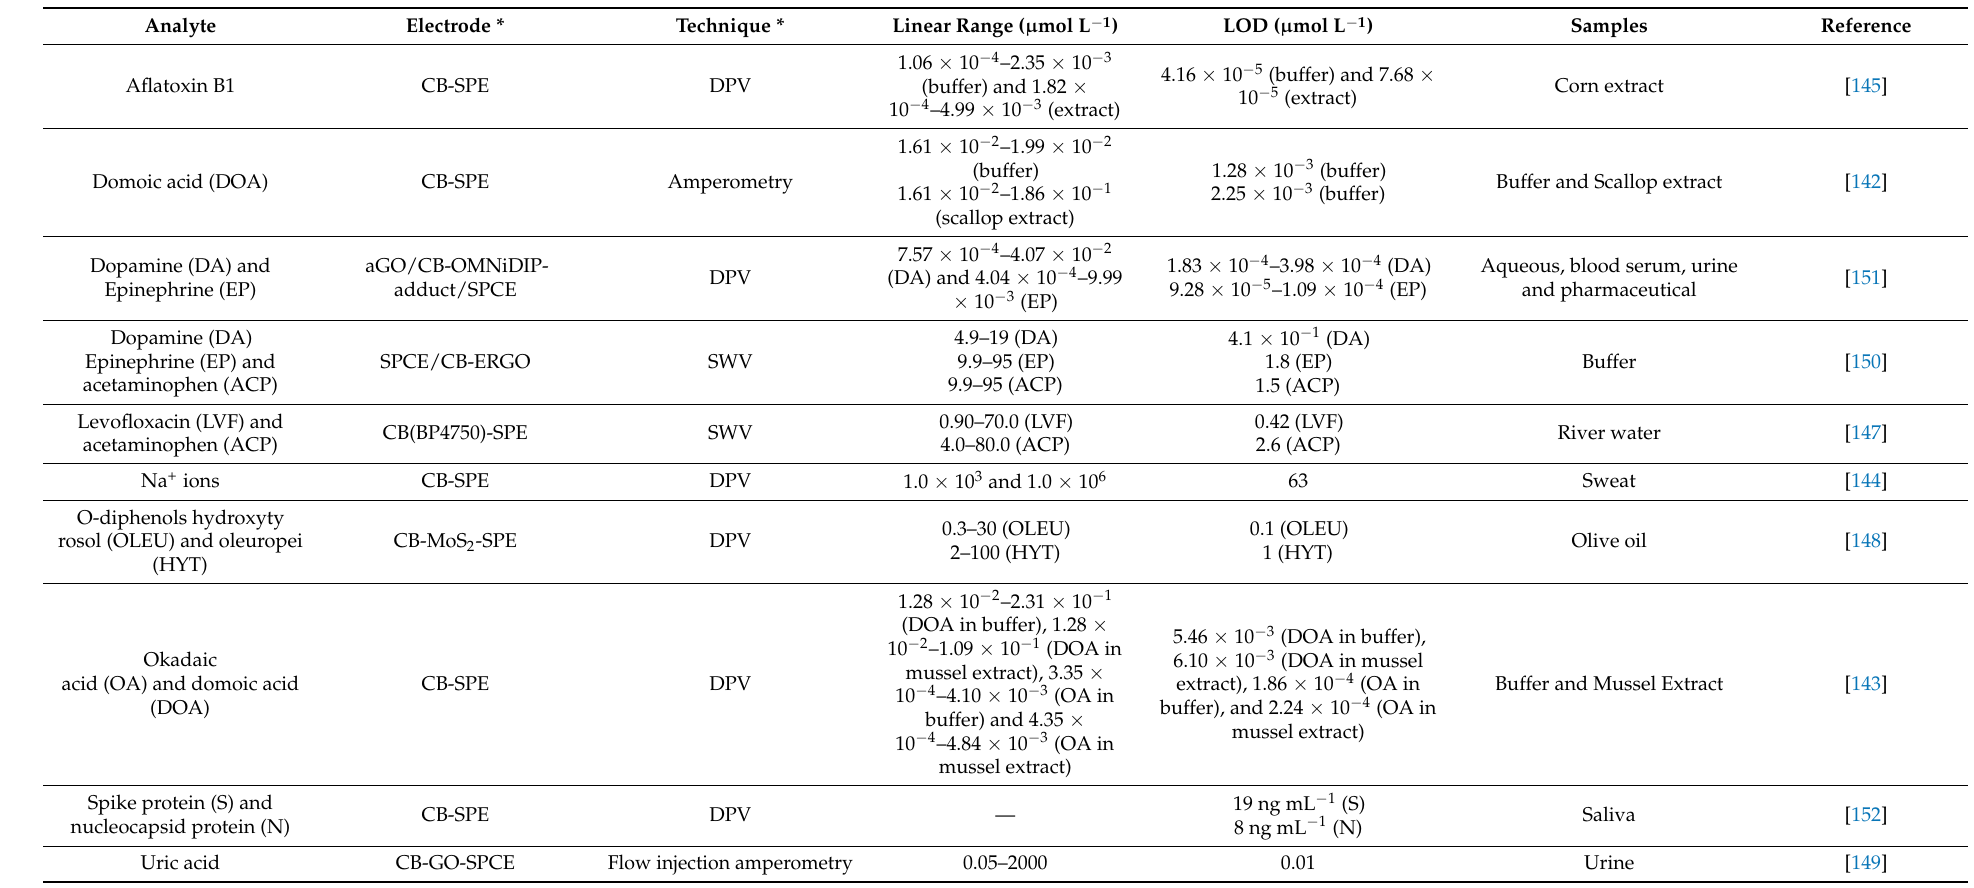
Table 3. Electrochemical sensors based on carbon black